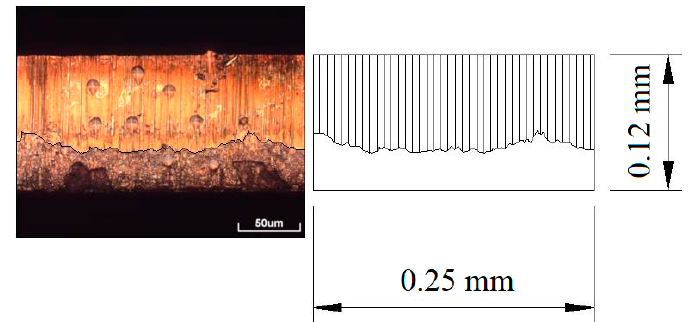
Figure 2. Schematic illustration of the blanked edge quality evaluation.